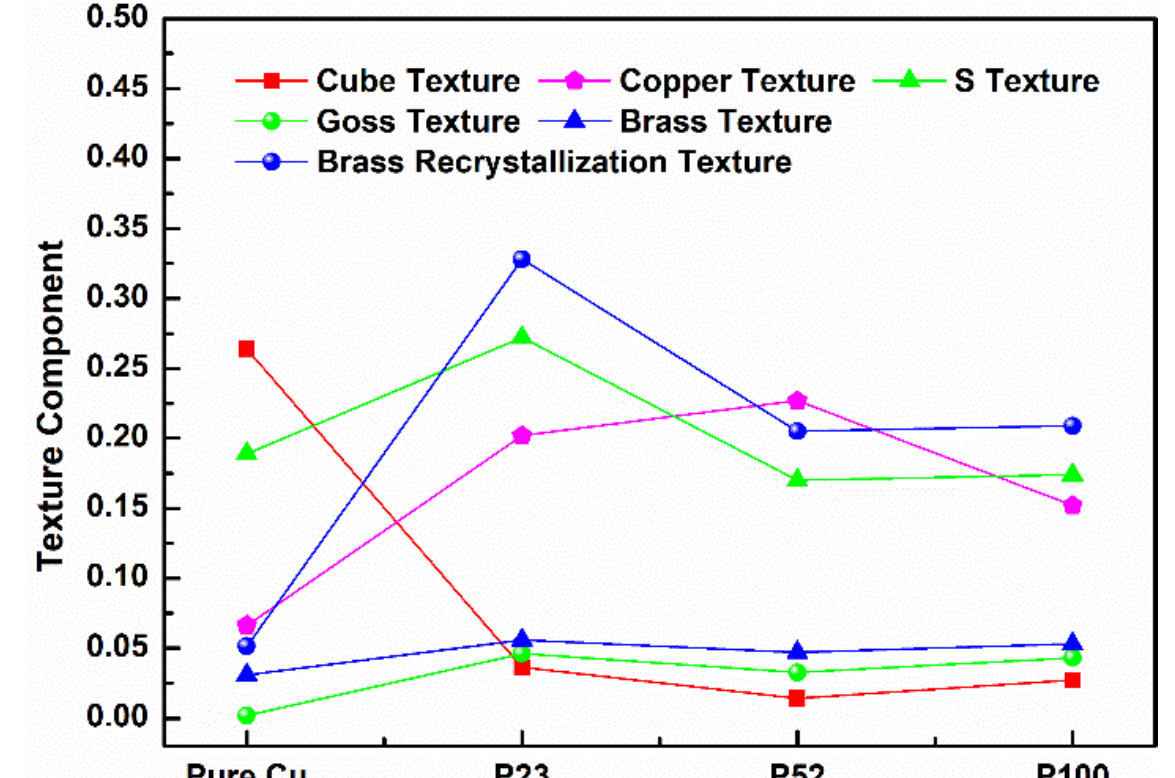
Figure 8. Texture components of the final cold rolled Cu specimens.